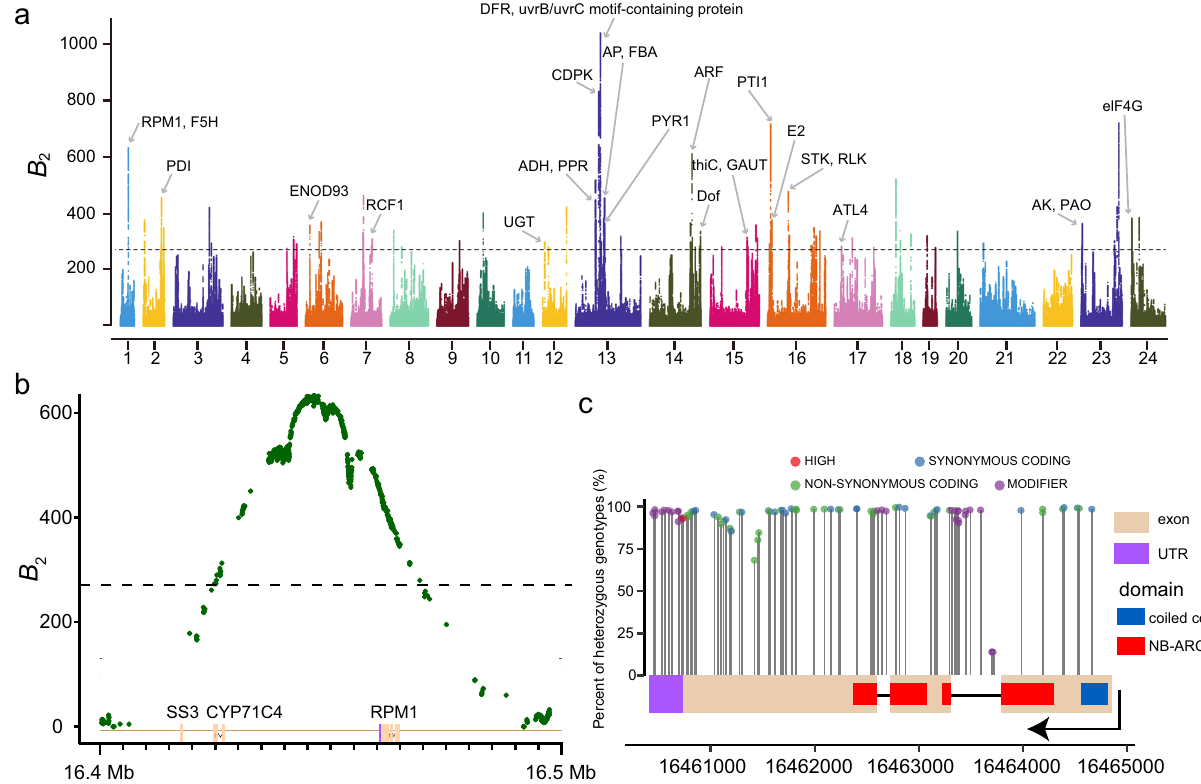
Fig. 2 Balancing selection in the moso bamboo population underlies adaptation. a Regions of balancing selection detected in the whole moso bamboo population based on B 2 statistics. The dashed line represents the signi fi cance level of the top 0.5%. The candidate genes under balancing selection are indicated using arrows with gene names (the full names of these genes are listed in Supplementary Data 13). b Enlarged diagram of B 2 statistics around the disease resistance gene RPM1 . The dashed line represents the genome-wide signi fi cance level of the top 0.5%. c The diagram shows the SNPs and heterozygous genotype frequency in the RPM1 gene region (UTR untranslated region, NB-ARC nucleotide-binding adaptor shared by APAF-1, certain R gene products, and CED-4). The function of SNPs was de fi ned and predicted by SnpEff. Source data underlying b and c are provided as a Source Data fi